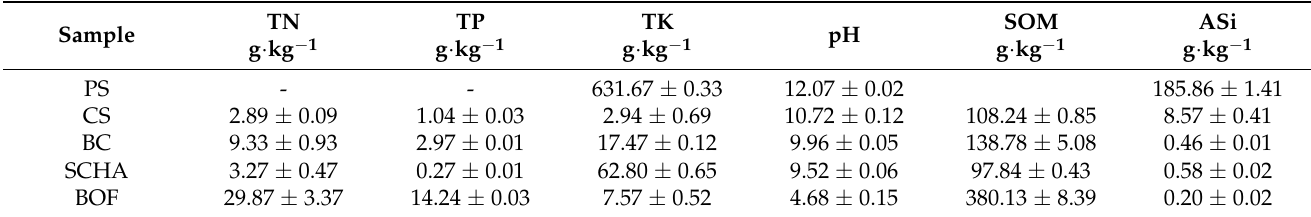
Table 1. The main physicochemical properties of the soil